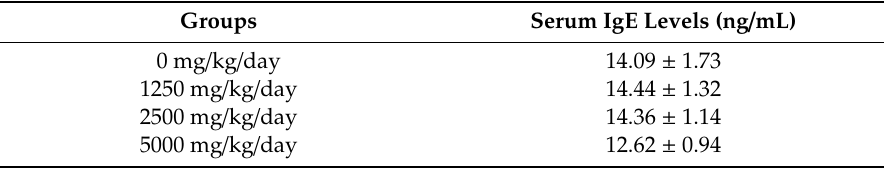
Table 6. Serum IgE level of SD rats orally administered frpfdZAL for 13